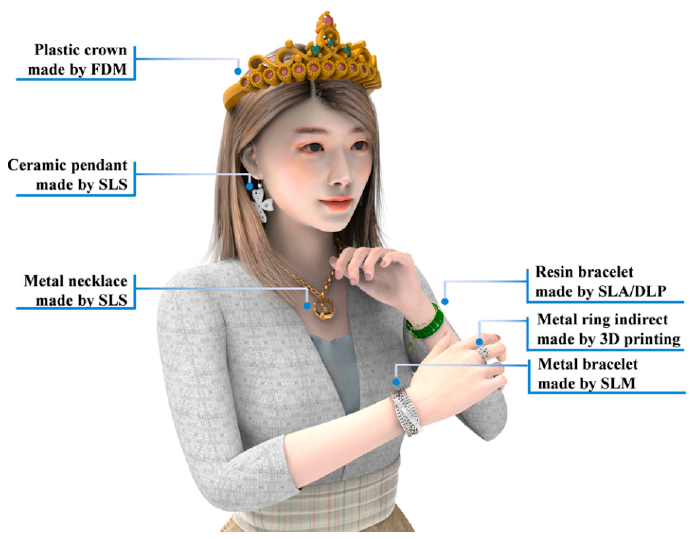
Figure 20. Examples of applications of AM in Jewelry and art decorations. Figure reproduced from [9].